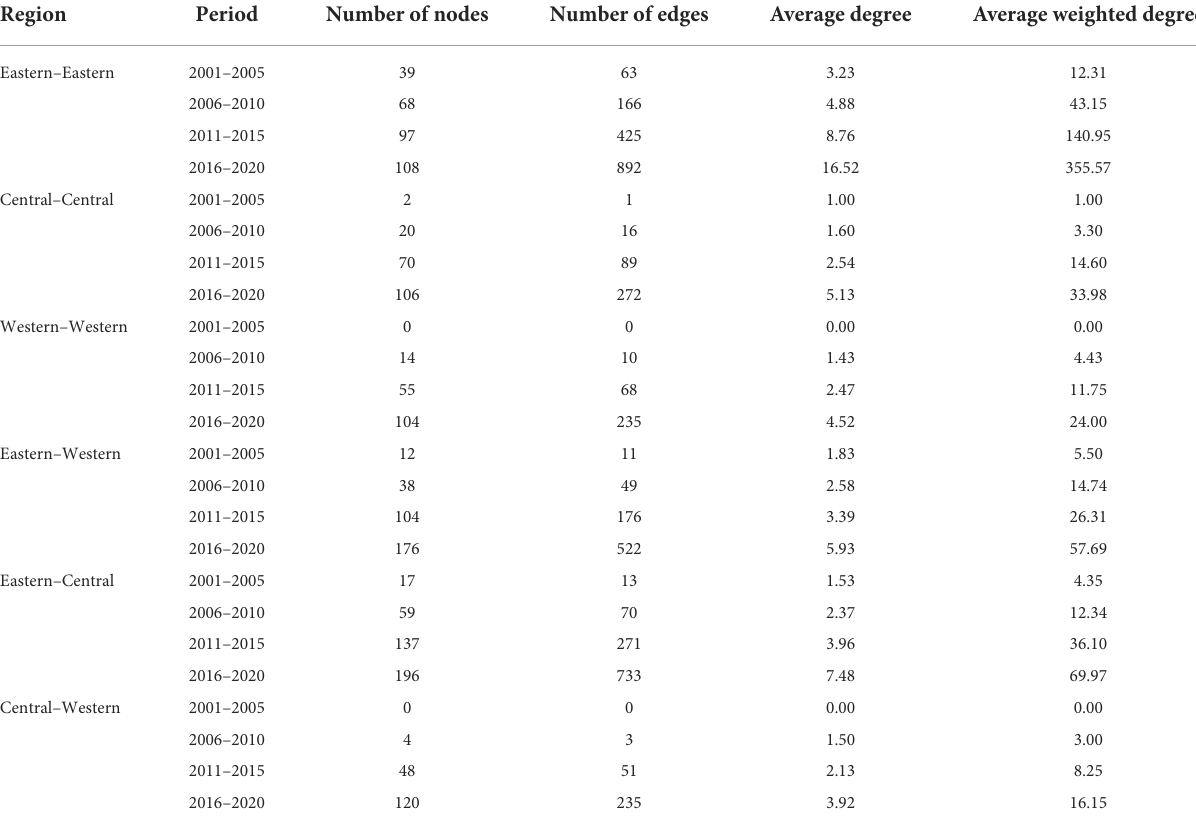
TABLE 3 Statistical characteristics of interregional urban biomedicine innovation networks among the eastern, central, and western regions of China. Region Period Number of nodes Number of edges Average